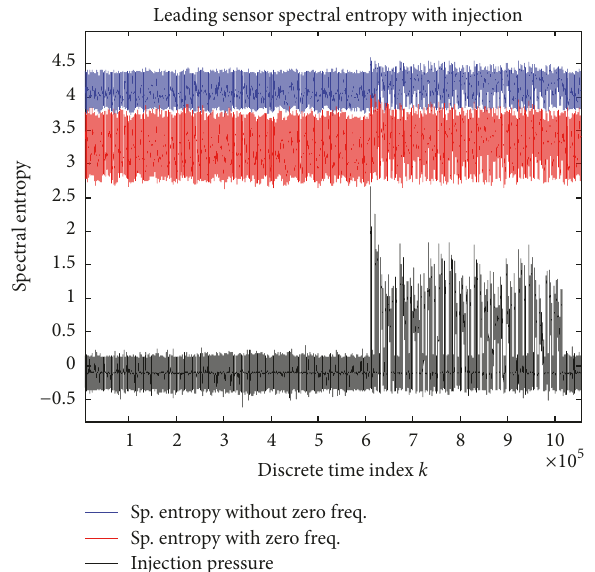
Figure 18: Spectral entropy for leading sensor. The first part of time series is without injection; second part is with injection.